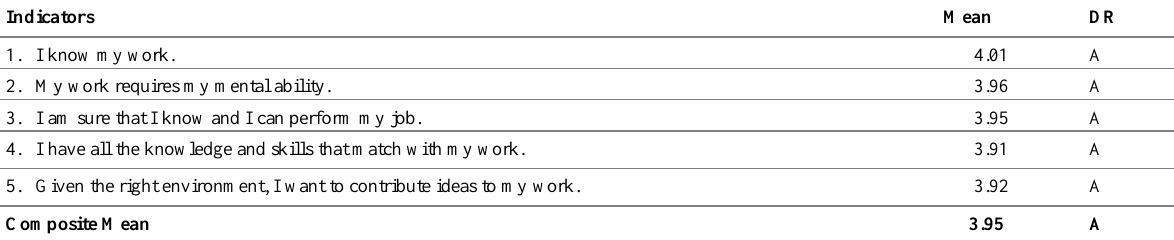
Table 8: The Work Engagement of Employees of Divine Word Colleges in the Ilocos Region in terms of Cognitive Engagement Indicators